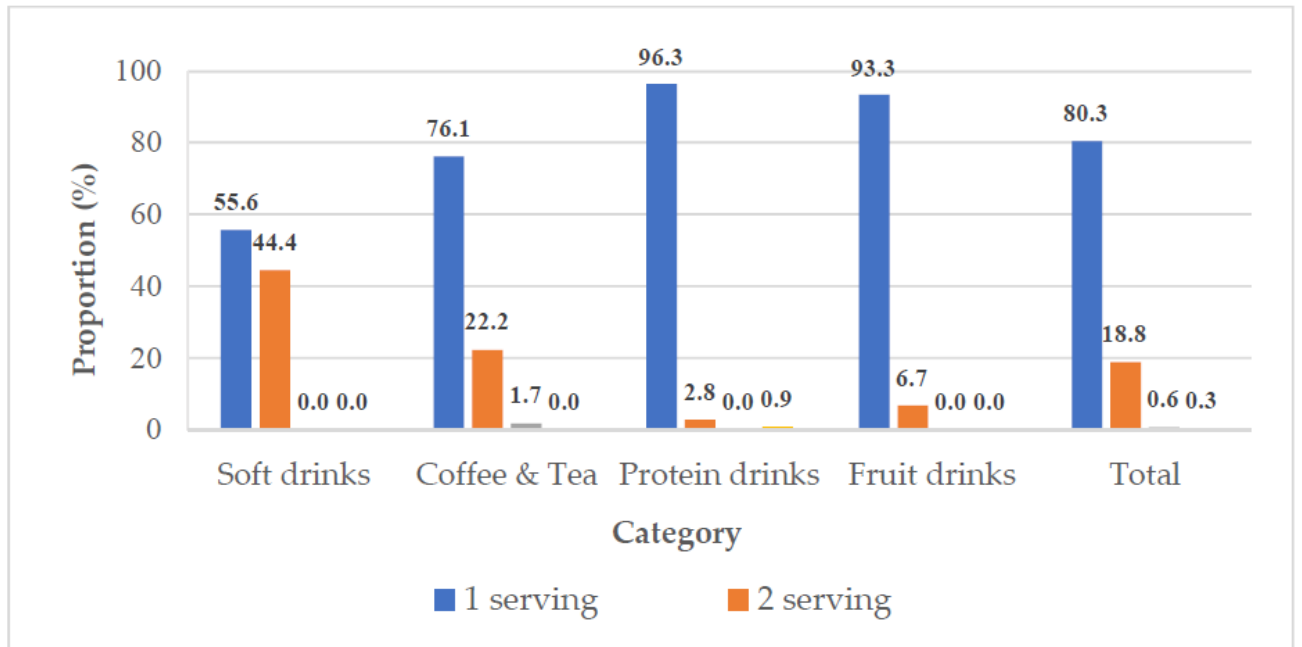
Figure 2. Distribution of servings per portion among different types of SSBs.